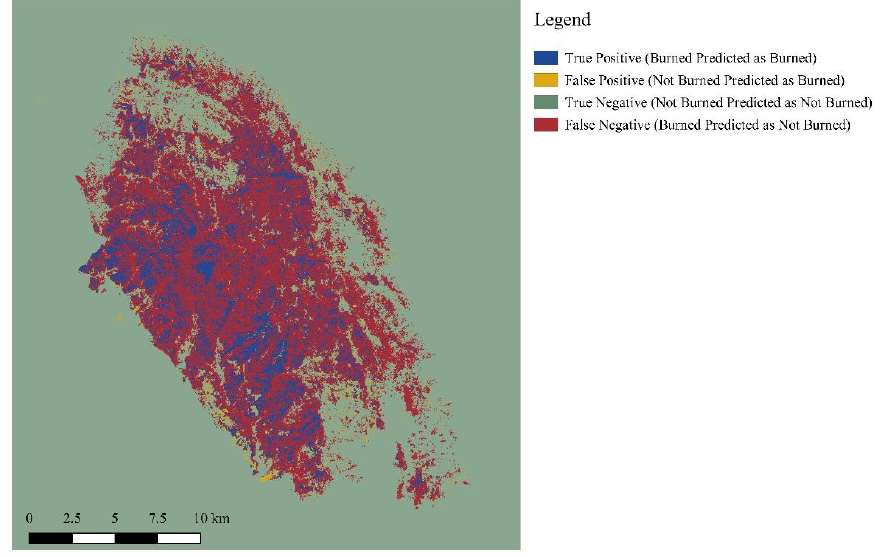
Figure 9. Segmentation result of U-Net_CZU_3.